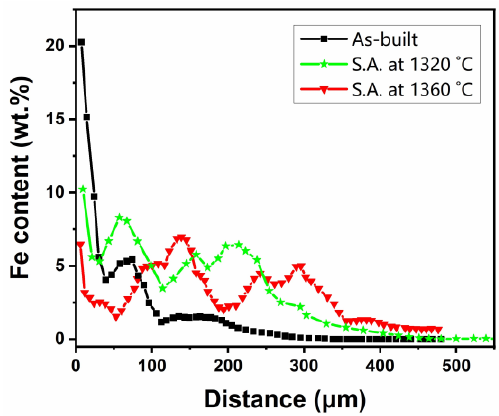
Figure 6. Fe content along the building direction in the three different conditions.